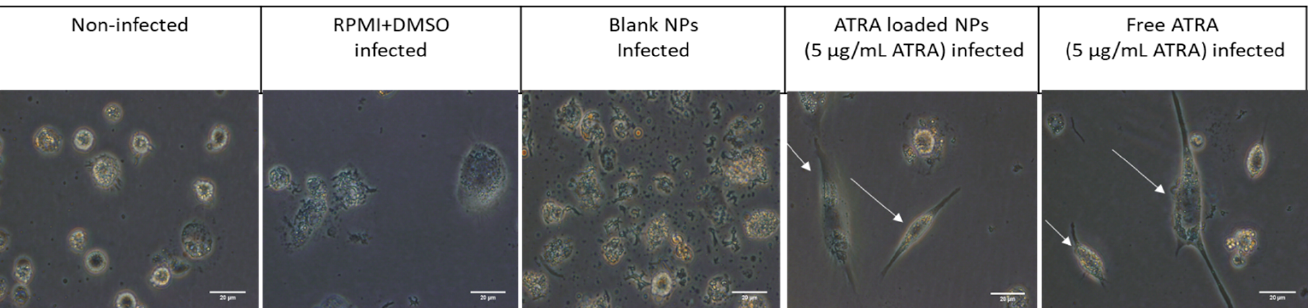
Figure 5. Fluorescent microscope images of cell morphology after 72 h of ATRA treatment (5 µ g/mL). THP-1 cells infected with H37Ra Mtb strain were treated with RPMI and DMSO, unloaded-NPs (blank NPs), 5 μ g/mL of free ATRA solution and ATRA-PLGA NPs (corresponding to 5 μ g/mL ATRA). Scale bar: 20 μ m. Arrows point at elongated macrophages.